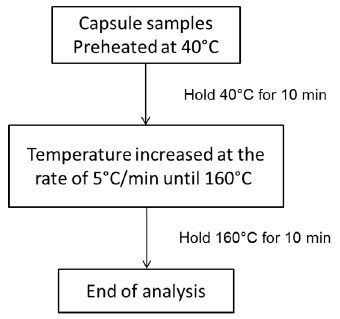
Figure 2. Thermogravimetric analysis ( TGA) temperature control program.